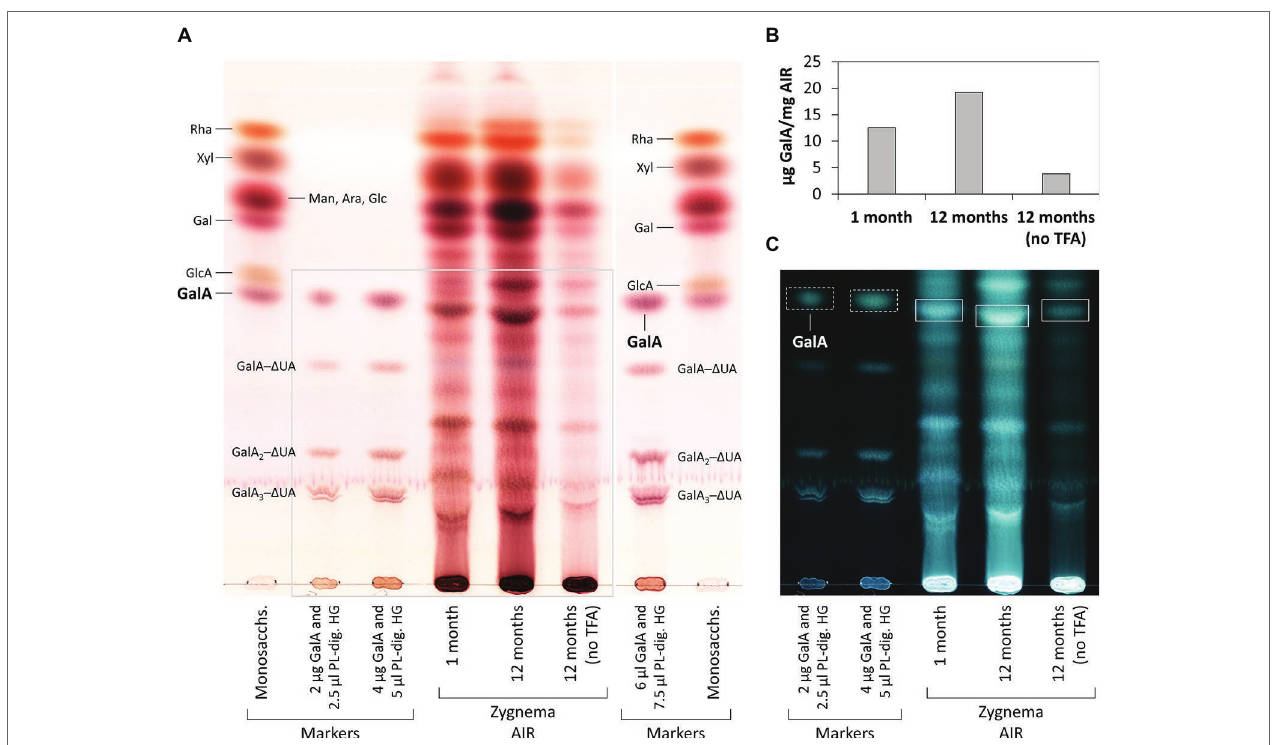
FIGURE 7 | Monosaccharide and oligosaccharide composition of young and old Zygnema AIR. (A) Samples were TFA-hydrolyzed or left in water and hydrolysis products separated by thin-layer chromatography (TLC). TLC plate area shown in (C) is marked with a grey line. (B) Quantification of GalA in AIR samples treated or not treated with TFA. (C) Same plate as in (A) , but shown with inverted colors. TLC marker bands as in Figure 6 . GalA bands in Zygnema AIR used for quantification (rectangles) and GalA marker bands (rectangles with dashed